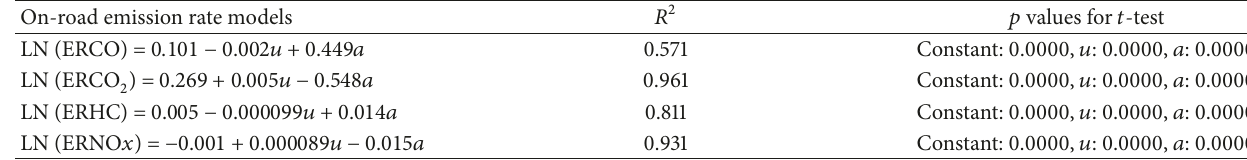
Table 4: On-road exhaust emission models of